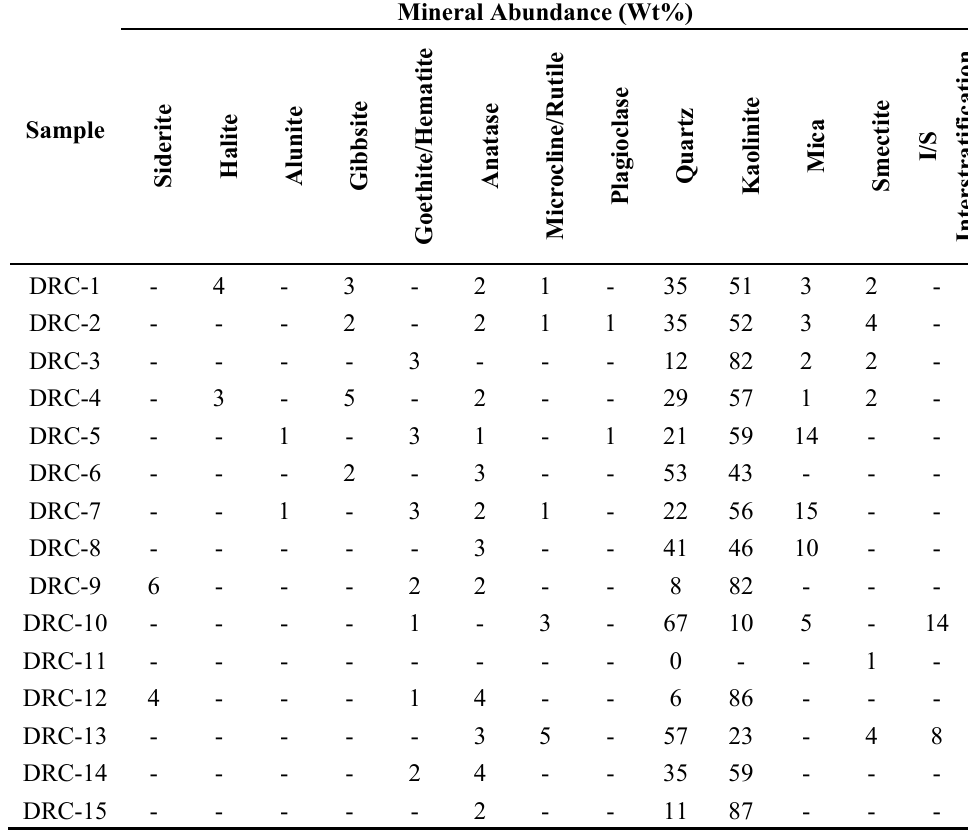
Table 5. Mineral assemblage of soil samples from